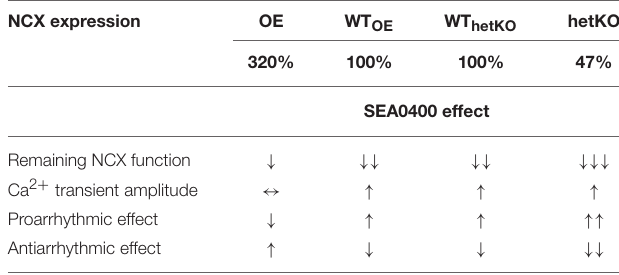
TABLE 1 | Summary of the effects of SEA0400 on Ca 2 + handling in dependence on the NCX expression